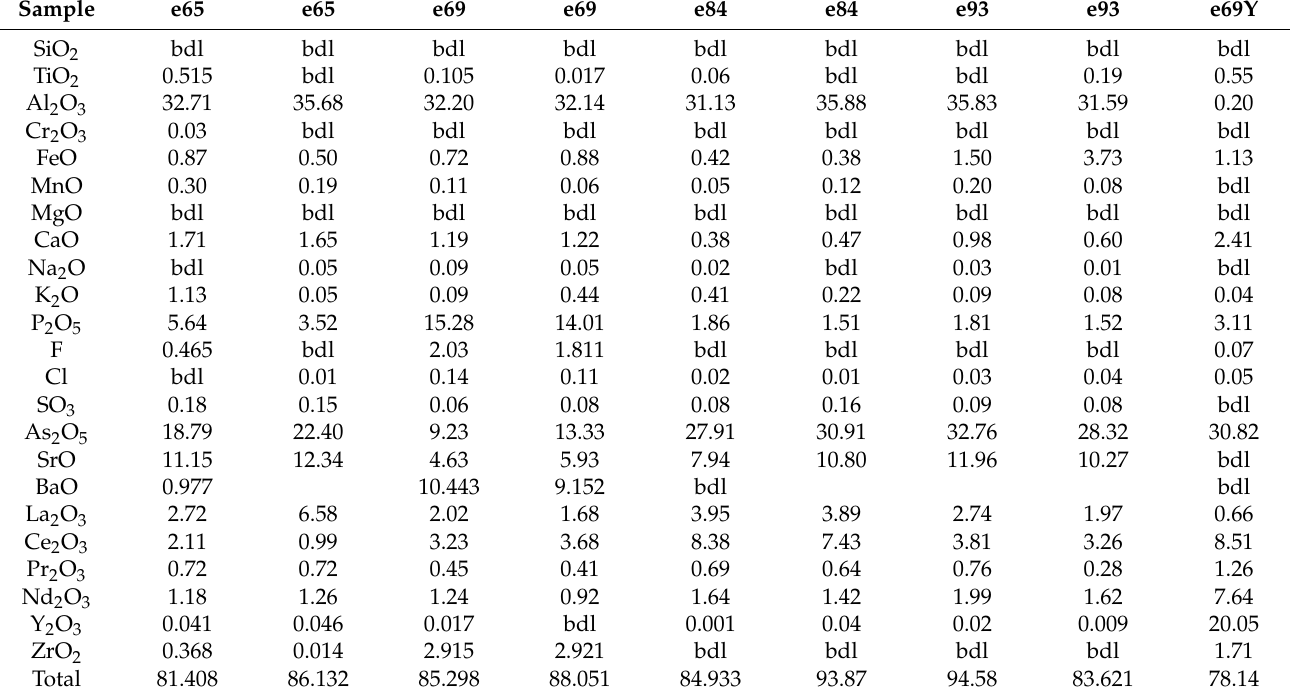
Table 4. Representative arsenic phase